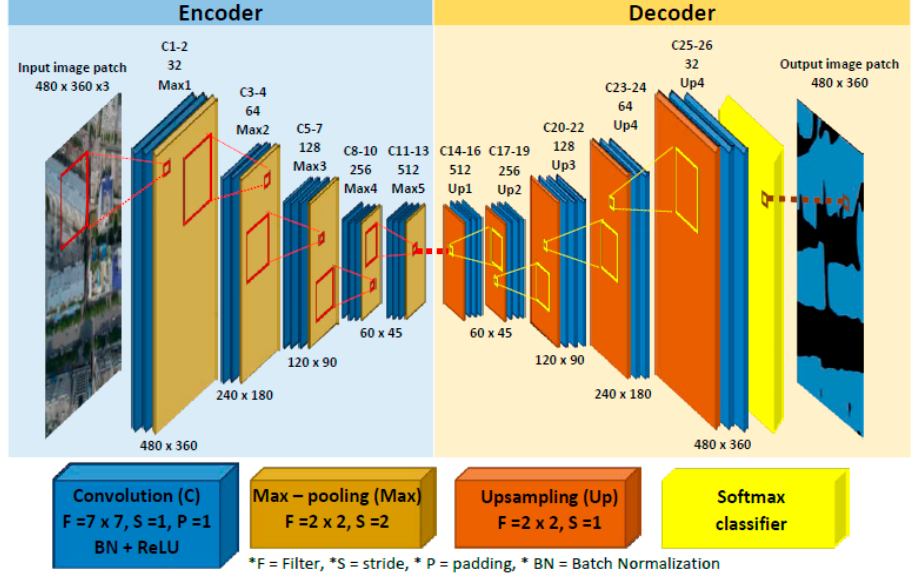
Figure 4. SegNet architecture for semantic labeling.